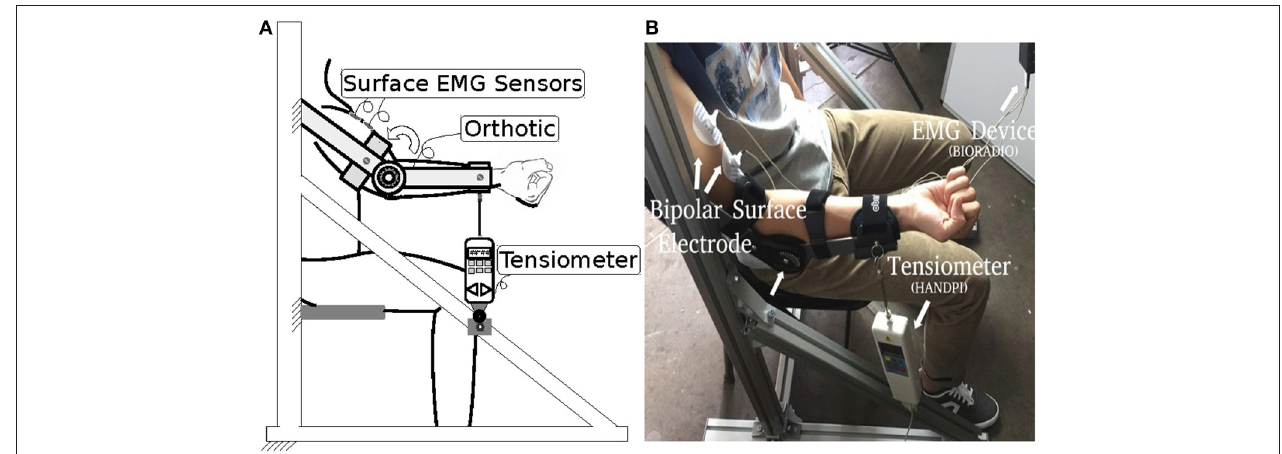
FIGURE 2 | Experimental setup (A) diagrammatic side view; (B)